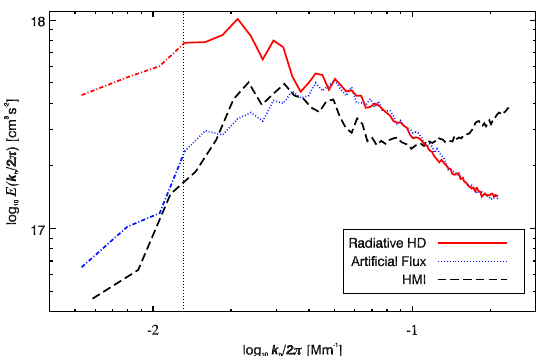
Fig. 15 Kinetic energy spectra in the radiative hydrodynamics simulations of Lord et al. (2014) (solid red line). The spectrum obtained by reducing artificially the velocities in the deep layers is shown in dotted blue line. The vertical line marks the scale of the largest modes driven in the simulation. The black dashed line corresponds to solar spectra obtained from SDO/HMI data and coherent structure tracking (black dashed line). Image reproduced with permission from Lord et al. (2014), copyright by